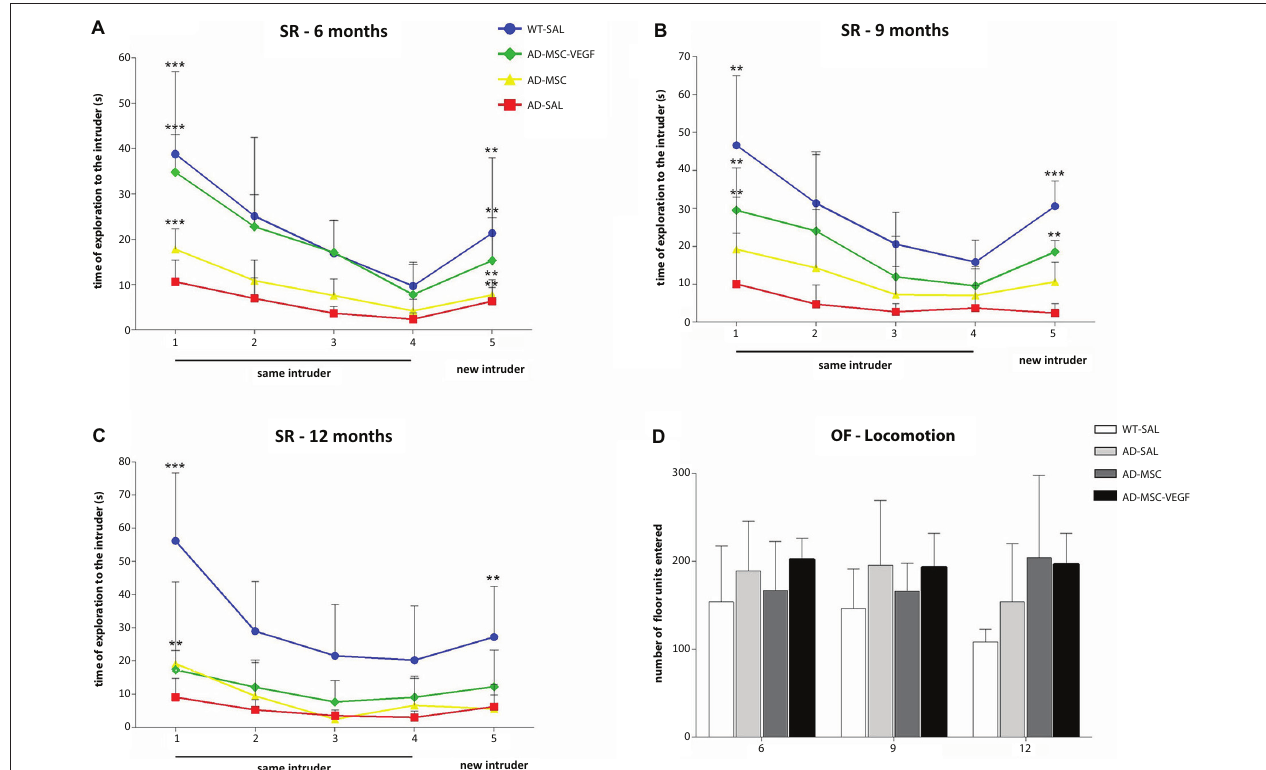
indicated in the trial number 1, and differences between the 4th and 5th trials are indicated in trial number 5. Color lines and point markers connect the mean values for the groups in each session (SAL-WT in blue; AD-MSC-VEGF in green; AD-MSC in yellow; AD-SAL in red). In (D) , the general locomotor activity of the WT and AD mice groups in the OF test for each age (6, 9 and 12 months), as evaluated by the total locomotion frequency of the quadrants traversed. There were no statistical differences between